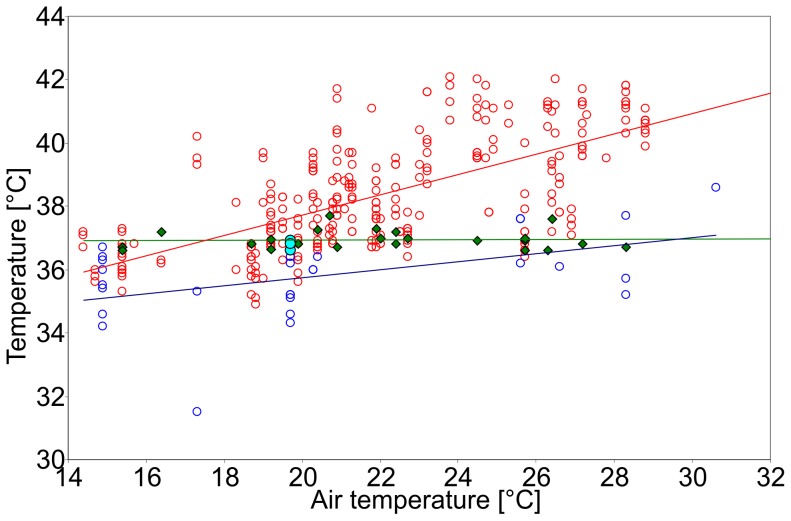
Tbody and Tskin of the pups with wet and dry fur.Tbody with dry fur (green diamonds, green regression line, N = 23) and wet fur (turquoise filled circles, N = 3) as well as Tskin with dry fur (red circles, red regression line, N = 279) and wet fur (blue circles, blue regression line, N = 28) against Tair. Mean Tskin with dry fur is 38.4±1.7°C, mean Tskin with wet fur is 35.8±1.3°C, which is significantly lower than with dry fur (p≤0.0001). Tbody is constant with no significant difference between wet and dry fur. The slope of regression of Tbody is with 0.002 again practically constant, while the regressions of Tskin ascend by 0.32 (dry fur) and 0.13 (wet fur).